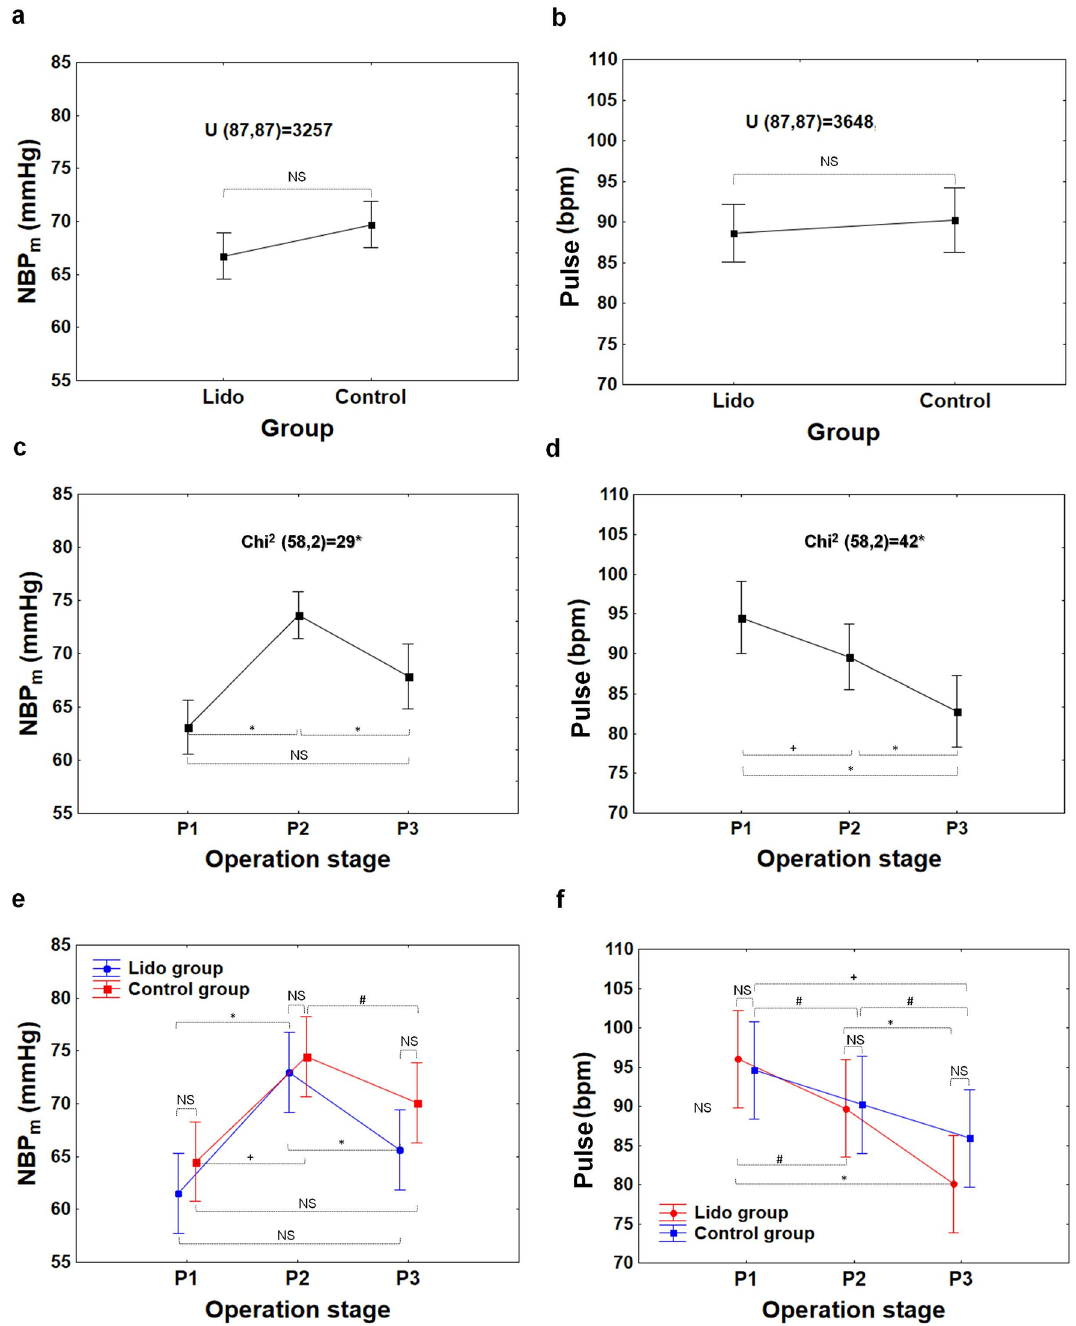
Figure 6. Mean blood pressure (NBP m ) and pulse rate (Pulse) from SpO 2 , at the beginning (P 1 −baseline), during (P 2 ), and at the end of surgery (P 3 ) in the Lido and Control group. The differences between patients’ groups are insignificant (NS), ( a , b ). The differences between the P 1 , P 2 and P 3 stages are significant ( c , d ). *P < 0.001; 1 − β = 0.97 at α = 0.001 ( c ); 1 − β = 0.95 at α = 0.05 ( d ). The difference between Lido and Control group at the P 1 , P 2 and P 3 level is insignificant (NS), ( e , f ). + P < 0.005, # P <